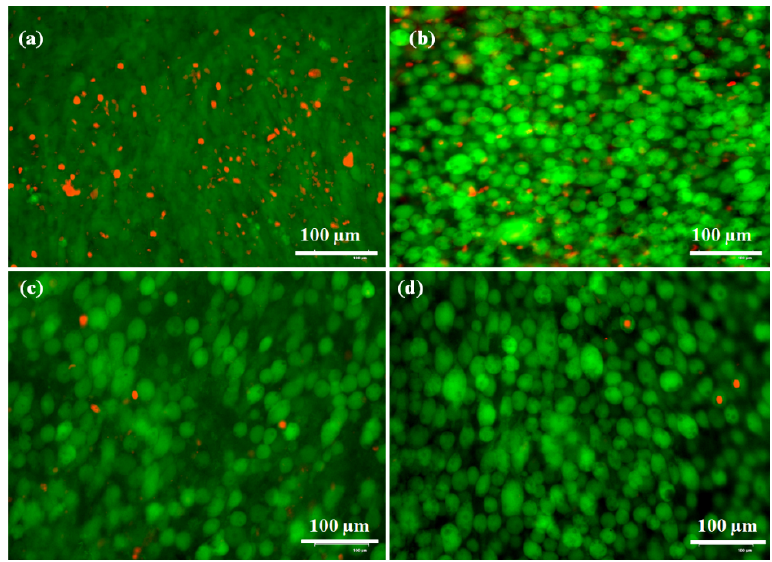
Figure 8. Optical images of osteoblast cells on the surface of zein / f-CNOs composite hydrogels after 3 days of study: ( a ) The control (tissue culture plate), ( b ) CZCNOs, ( c ) MZCNOs, and ( d ) UZCNOs; green indicates LIVE cells, and red indicates DEAD, respectively. Scale bar = 100 μm.